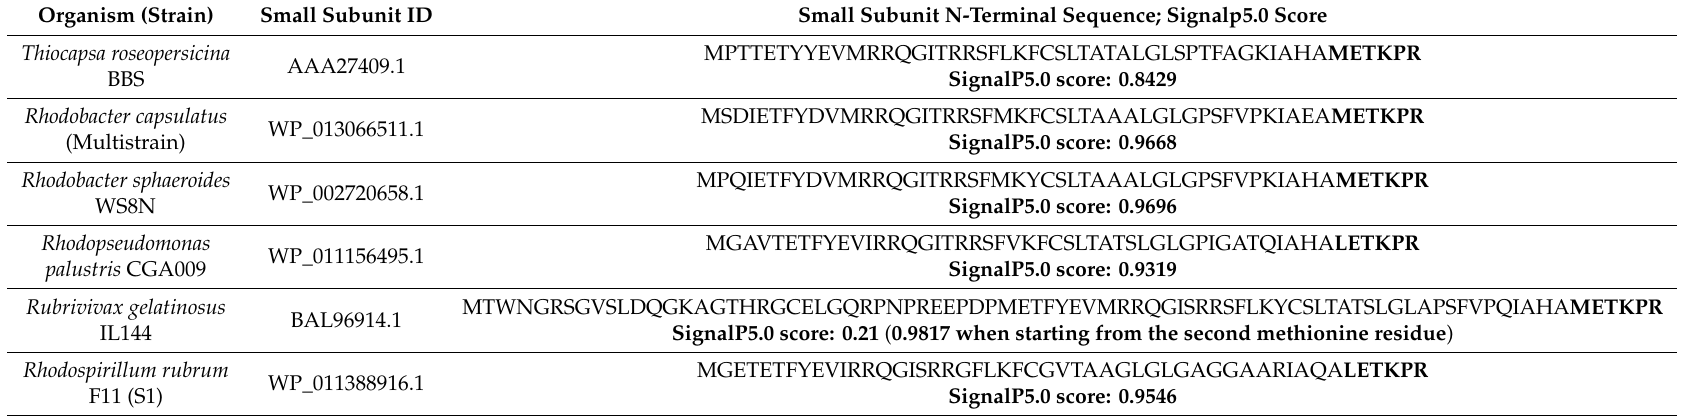
Table A3. Lists of sequences removed from the small subunits of hydrogenases before 3d structure modeling. Six residues comprising the N-end of mature small subunit are shown in bold type. For Rubrivivax gelatinosus , higher score predicting reliable cleavage of TAT peptide was observed when starting from the second methionine